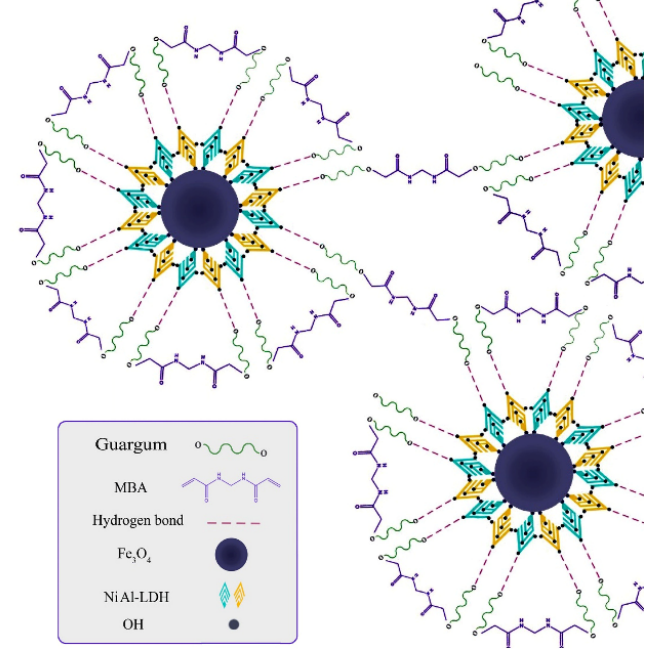
Figure 4. A scheme illustrated the synthesis process of cross-linked GG-NiAlLDH-Fe 3 O 4 biological nanocomposite [116].